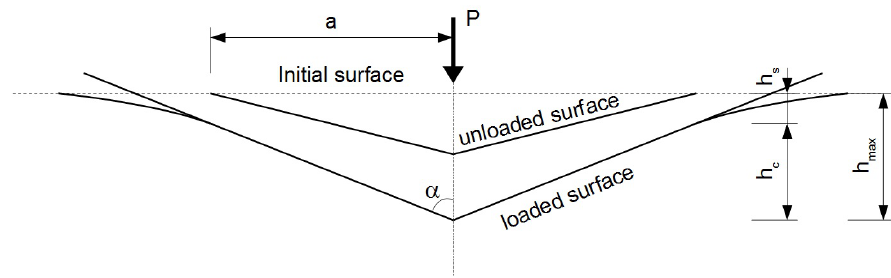
Figure 5. Scheme of the simulation under the